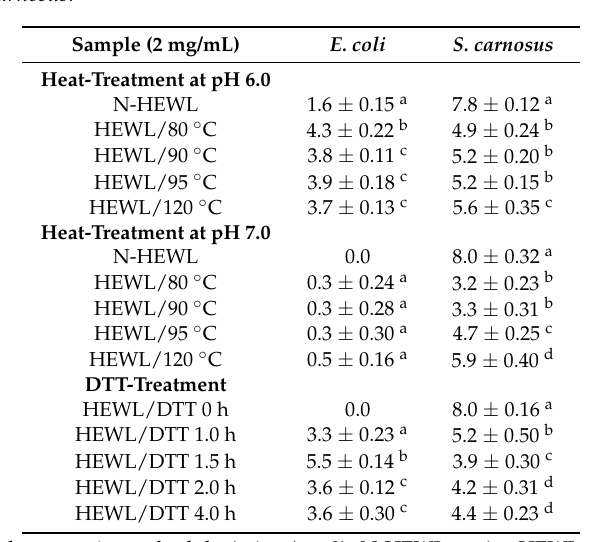
Table 1. Antibacterial activity of modified hen egg white lysozyme (HEWL) against at Escherichia. coli and Staphylococcus carnosus.